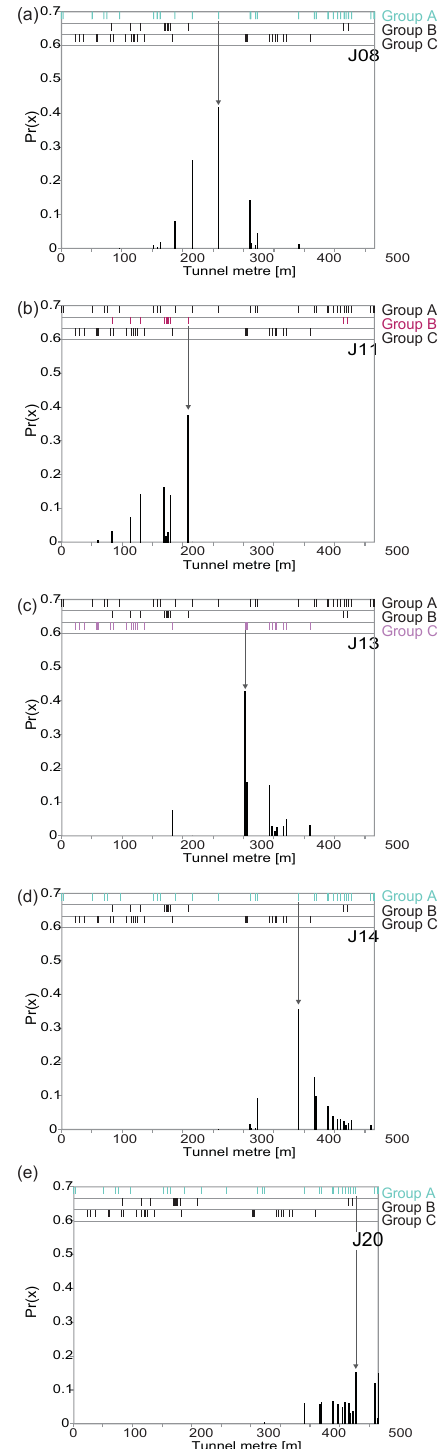
Figure 9. Probability distributions of five selected examples: panels (a) to (d) show the highest probabilities achieved, whereas panel (e) shows an example without clear maximum probability. On top, the positions of the underground deformations zones are indicated and grouped according to their strike. Additionally, the maximum a posteriori interpolation is highlighted with an